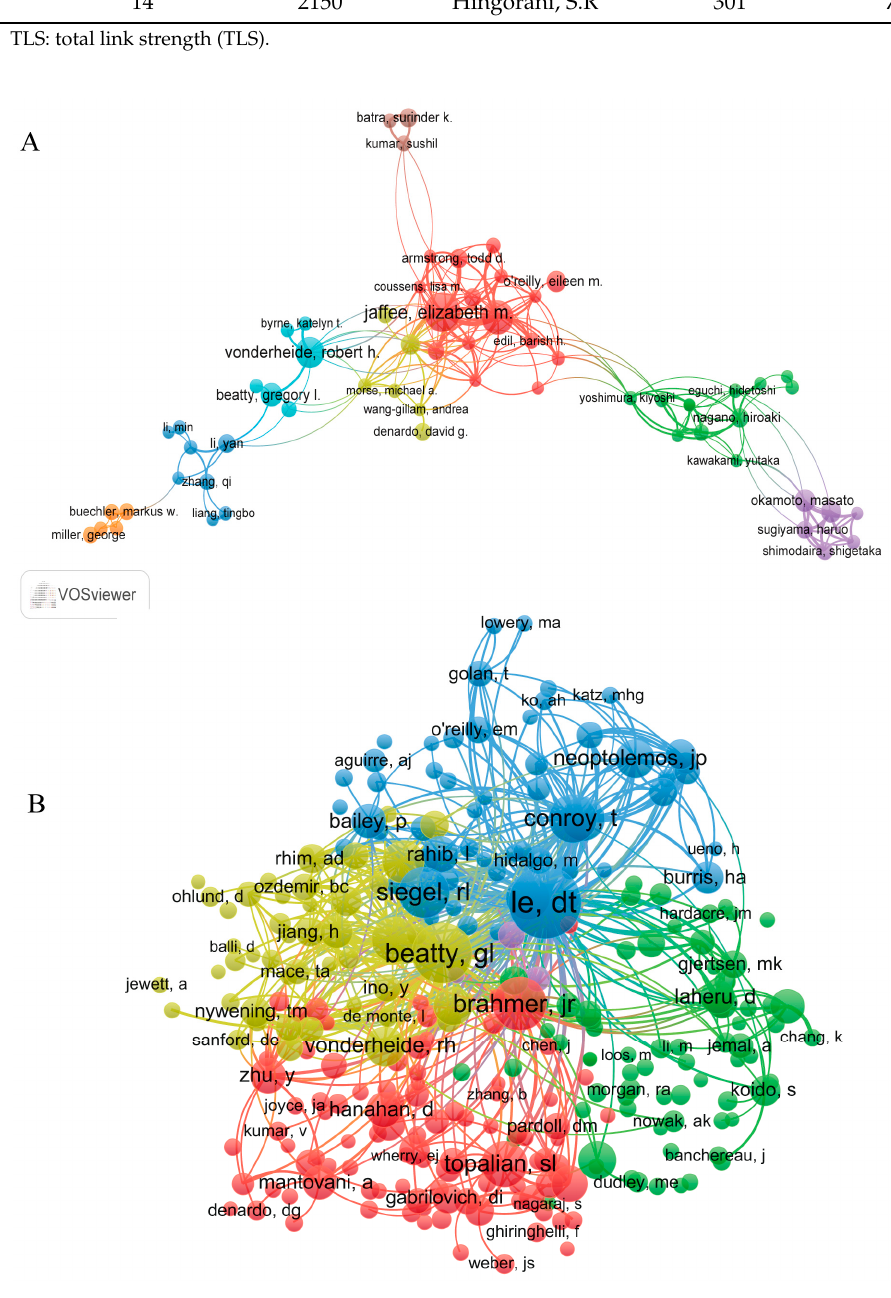
Figure 4. The cooperation map of authors ( A ) and co-citation map of authors ( B ) conducted with VOSviewer.